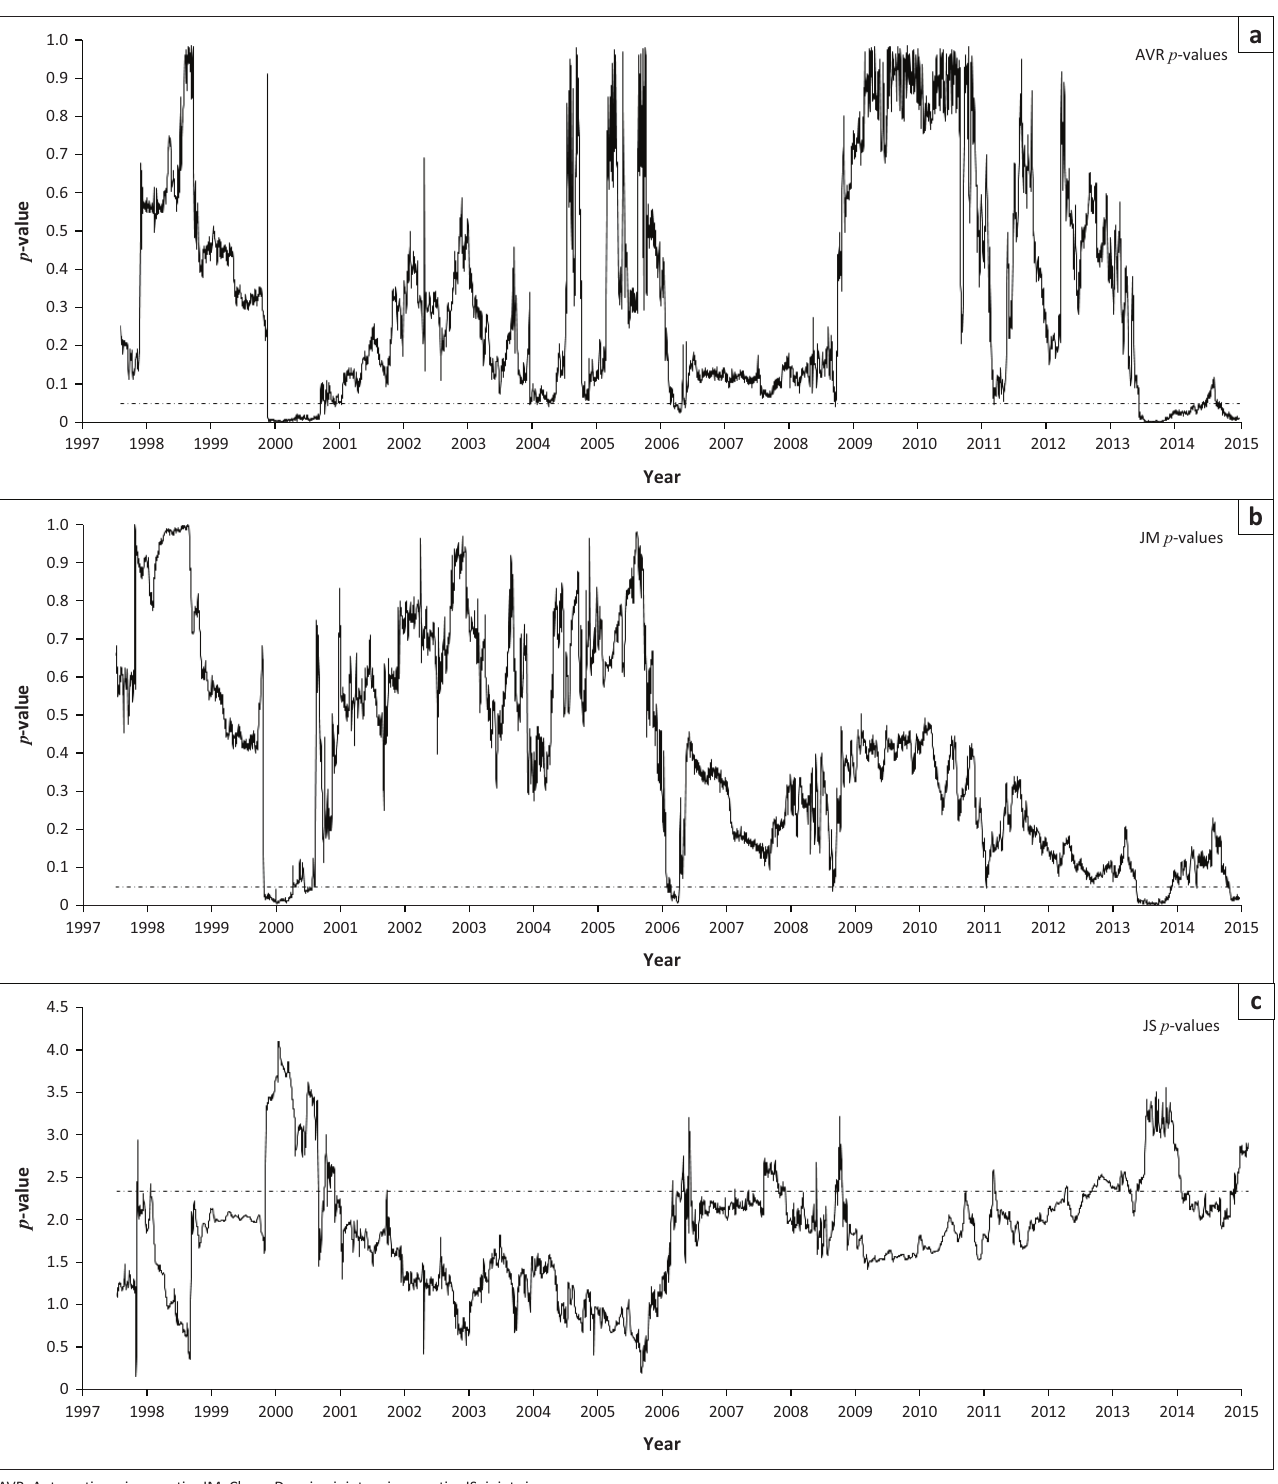
FIGURE 1: J203 – All share index: (a) AVR p -values, (b) JM p -values, (c) JS p